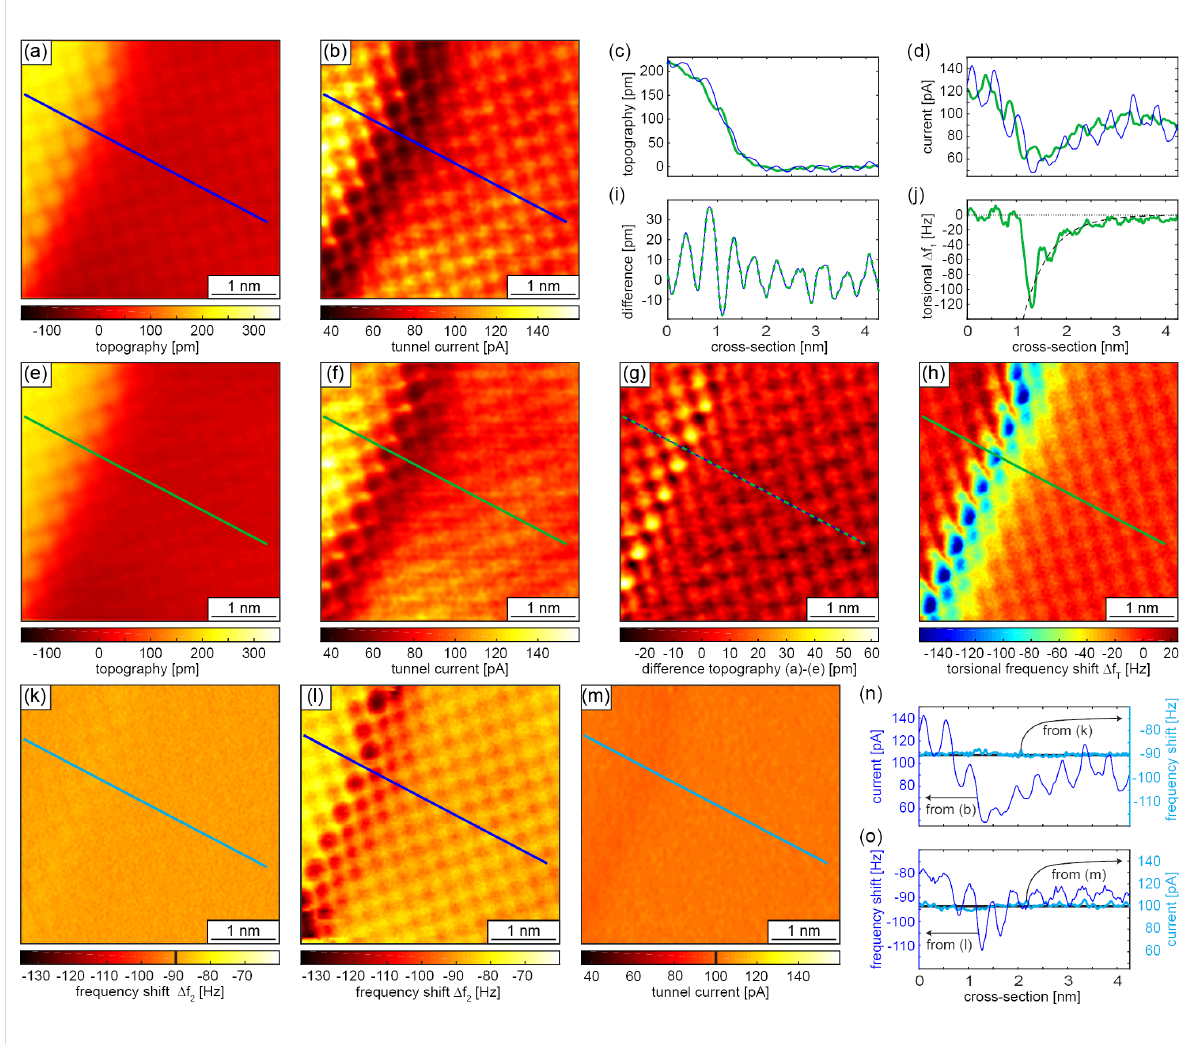
Figure 13: Multichannel and multimodal AFM results obtained on a NaCl island running over a Au(111) step edge. (a) Topography and (b) tunnel cur- rent images obtained with the second flexural mode frequency shift Δ f f2 = − 90 Hz and a second mode oscillation amplitude A f2 , rms = 100 pm. The blue lines in panels (c) and (d) represent the cross sections taken at the location of the blue lines in (a) and (b), respectively. Panels (e) and (f) show the same quantities as panels (a) and (b) but with the cantilever oscillated simultaneously in its first torsional mode with a torsional mode amplitude A t1 , rms = 60 pm to obtain the torsional mode frequency shift image Δ f t1 ( x , y ) displayed in panel (h). A large lateral attractive force is observed when the tip is approached to the step edge from the lower terrace side. See green cross section in panel (j). Because of the additional lateral tip oscillation, the topographical corrugation in panel (e) is slightly reduced compared to that in panel (a). Compare also the topography and tunnel current cross- sections, that is, the green and blue lines in panels (c) and (d), respectively. The reduction of the topographical corrugation is particularly pronounced at the step edge as visible in the difference data displayed in panel (g) calculated by subtracting the data shown in panel (a) from that displayed in panel (e). (i) The green dashed cross section in panel (g). (k) The frequency shift error observed during the constant frequency shift imaging used for the data displayed in panels (a) and (b). Alternatively, the tunnel current can be kept constant. Then the frequency shift shows an atomic-scale contrast (l). The corresponding tunnel current error image is displayed in panel (m). Panels (n) and (o) show the tunnel current and frequency shift variations along the cross sections indicated by the lines in panels (b) and (l), respectively, while the frequency shift or tunnel current is kept constant (pale blue lines in panels (n) and